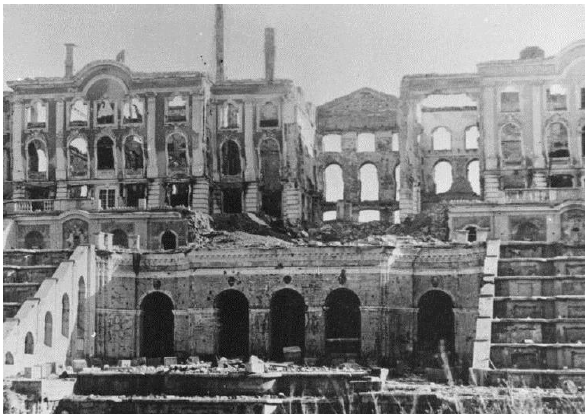
Figure 1. Central part of the Grand Palace and the Grand Cascade of Peterhof after the damages of WWII. © Boris Lobovikov archive